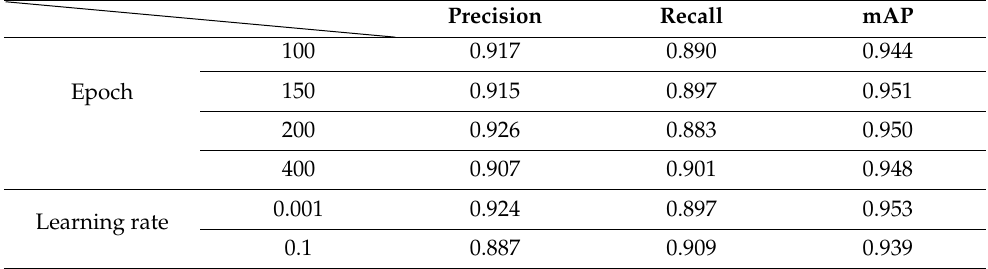
Table 8. Performance resolution based on hyperparameters.